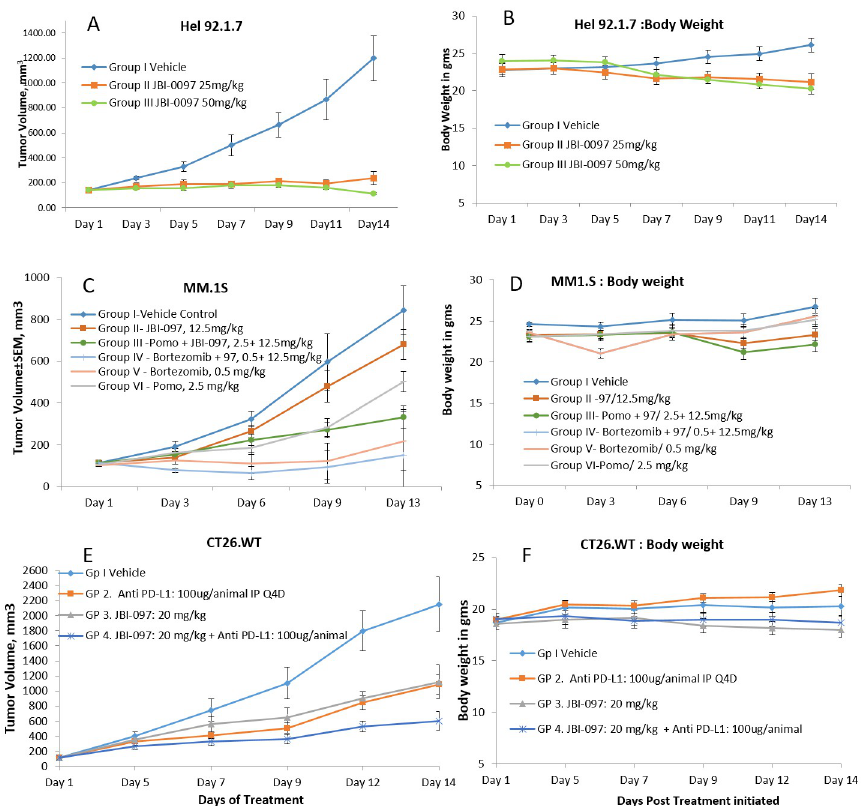
Fig 5. Efficacious of JBI-097 in multiple Xenograft models. 5A: SCID mice were injected s.c. with 5 × 10 6 HEL 92.1.7 cells and were treated with vehicle, JBI-097 (25 and 50 mg/kg, po, QD), for 14 d.; n = 6 mice per group. 5B : HEL92.1.7 xenograft: Body weight monitored from Day1 to Day14; n = 6 mice per group. 5C: SCID mice were injected s.c. with 5 × 10 6 MM1.S cells and were treated with vehicle, JBI-097 (12.5 mg/kg, po), Bortezomib (0.5 mg/kg, IP, BIW), Pomalidomide (2.5mg/kg, po, 5x/week), or Bortezomib + JBI-097 or Pomalidomide + JBI-097 for 13 d.; n = 7 mice per group. 5D : MM1.S xenograft: Body weight monitored from Day1 to Day13; n = 7 mice per group. 5E: BALB/ c mice were injected s.c. with 1 × 10 6 CT-26 cells and were treated with vehicle, JBI-097 (20 mg/kg, po), Anti PD-L1 (100 μ g/animal, IP, Q4D), or Anti PD-L1 + JBI-097 for 14 d.; n = 7 mice per group. 5F : CT-26 syngeneic model: Body weight data from Day1 to Day14; n = 7 mice per group. All data are represented as mean ± SE. In all the studies tumor volume was measured and calculated versus time (days).